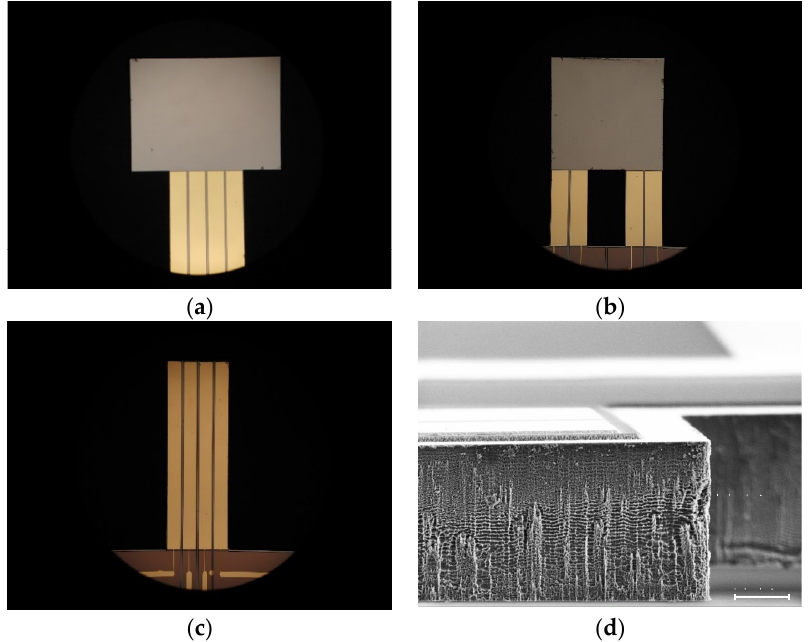
Figure A1. Microscopic image of the three different micro-oscillator structures: PO ( a ), BO ( b ), and CO ( c ) and a scanning electron microscope image illustrating the side view on a micro-oscillator revealing a thickness of 27 µm ( d ).